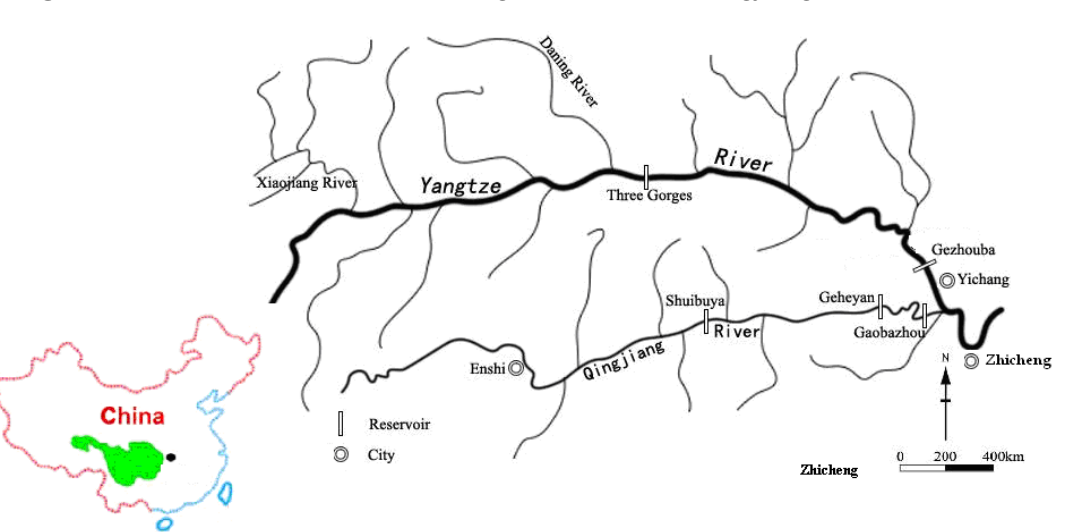
Figure 1. The location of the Three Gorges cascade and Qingjiang cascade reservoirs.